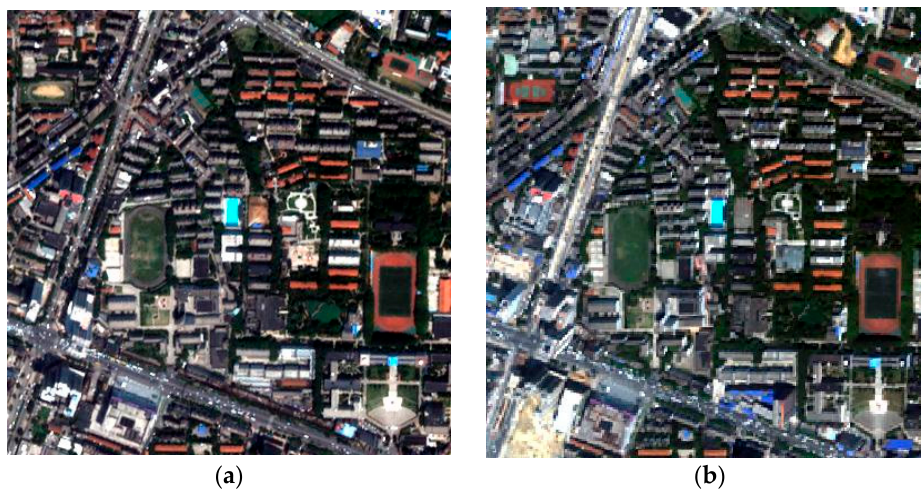
Figure 3. Interpolated bi-temporal images of the first study area. ( a ) Acquired by QuickBird in April 2005 (L1); and ( b ) acquired by IKONOS in July 2009 (L2).